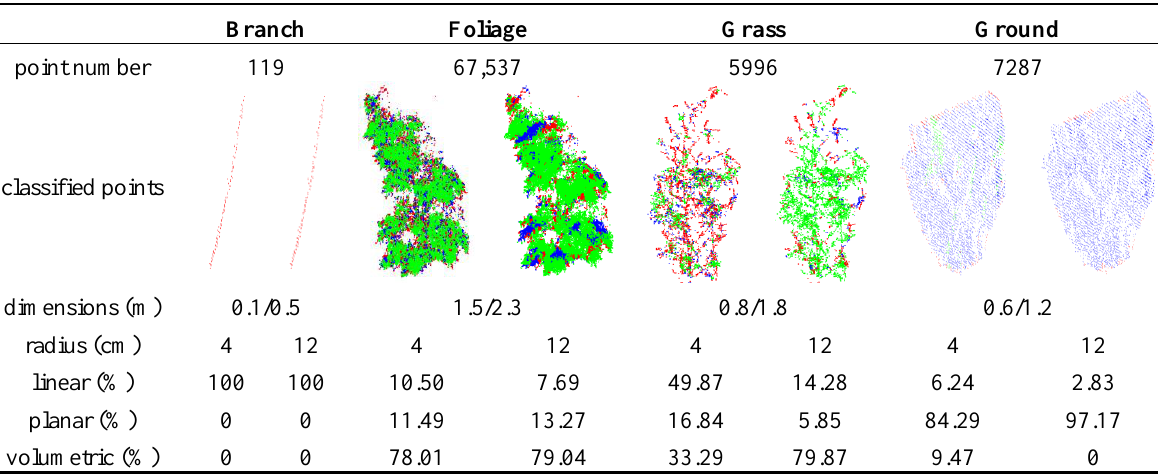
Table 2. Percentages of classified features in other